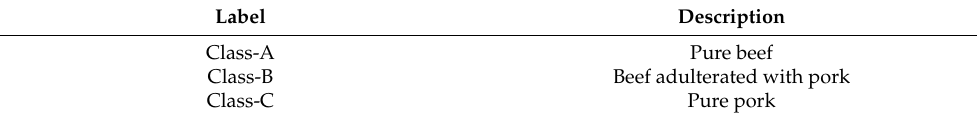
Table 2. Detailed description of classes labeled Class-A, Class-B, and Class-C.